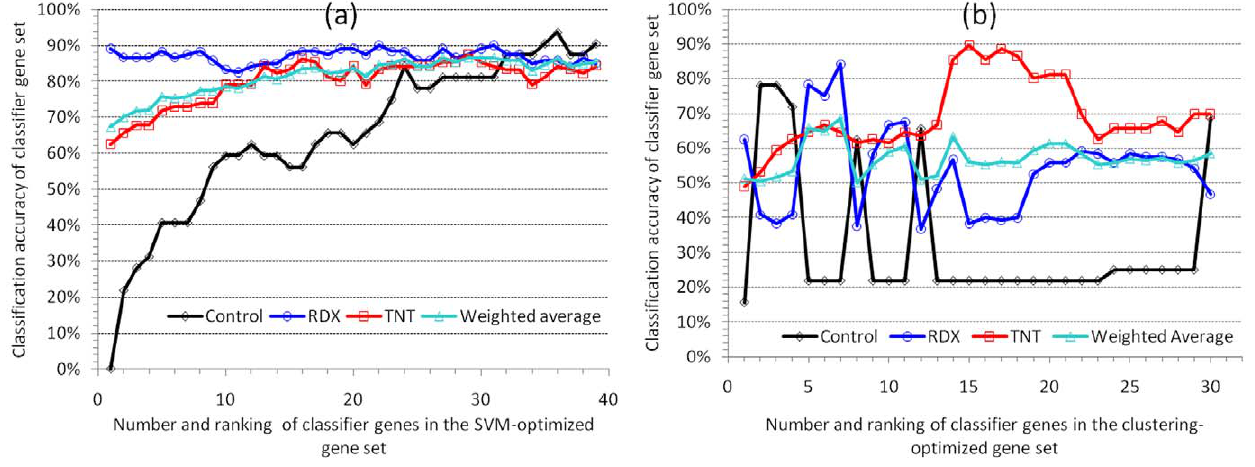
Figure 5. Classification accuracy of the 248 earthworm samples using an increasing number of classifier genes optimized by SVM (a) or clustering (b). The weighted average accuracy and the accuracy for each of the three classes (control, RDX and TNT) are shown for each set of genes (1 , 39 genes in 5(a) or 1 , 30 genes in 5(b)). One gene (the next highest ranked gene) at a time was added to the previous gene set to generate a new gene set (see also Figure 3